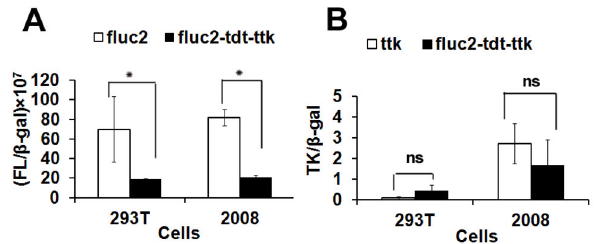
Figure 1. Comparative expression analysis of pcAGGS-fl2- tdt-ttk vector in 293T and 2008 cells by transient transfection. (A) A ratiometric analysis of firefly luciferase and β-galactosidase activity show 2-3 fold lower luciferase activity of the pcAGGS-fl2-tdt-ttk construct in comparison to pCMV-fl2 vector in both 293T and 2008 cells. (B) Ratiometric analysis of thymidine kinase activity and β-galactosidase activity revealed slightly higher TK in 293T cells, but slightly lower TK activity in 2008 cells by the triple fusion vector in comparison to CMV-ttk vector. (ns. -statistically non-significant and *indicates